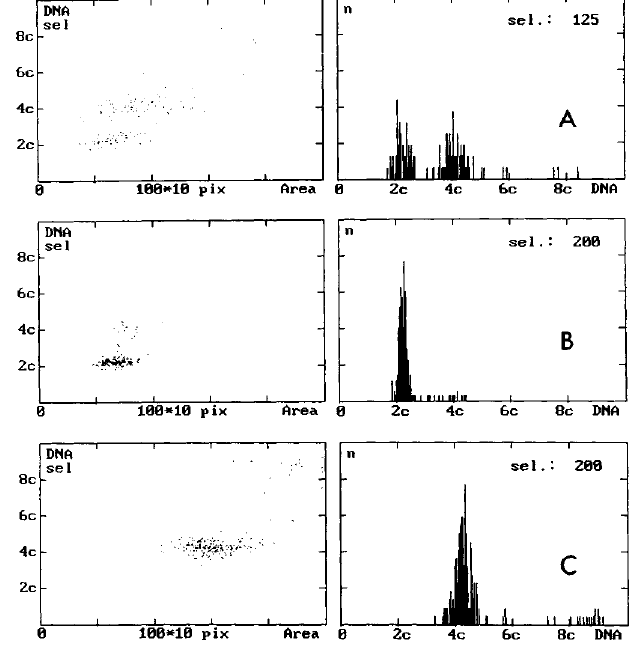
Fig. 1. Pairs of result panels of the ACAS program after measurements for DNA histograms with different sampling rules from a single sample. The measurements were made from a prostatic FNAB sample fixed in ethanol and diagnosed as definitely malignant (class 5). The left panels show a scatter-plot of DNA ploidy (vertical axis) and cell size in pixels (horizontal axis). The right panels show the DNA histograms. In all presented cases control cells were set at 2c and showed a thin peak (CV 6 4.5%), but are not shown in the panels because of space constraints. At Fig. A nuclei were selected at the periphery of marked cell groups, and all overlapping nuclei were avoided. The histogram demonstrated broad peridiploid and peritetraploid peaks, and corresponding nuclear size classes could be demonstrated. At Fig. B medium sized cells between cell groups were selected. A peridiploid peak was produced. At Fig. C only large epithelial nuclei between cell groups were selected. Now the nuclei were much larger, and correspondingly no peridiploid nuclei are seen. But we see a broad peak representing tetraploid or hypertetraplod nuclei. The control lymphocytes defined the location of 2c. The numbers of cells selected for analysis are shown in the panels on the